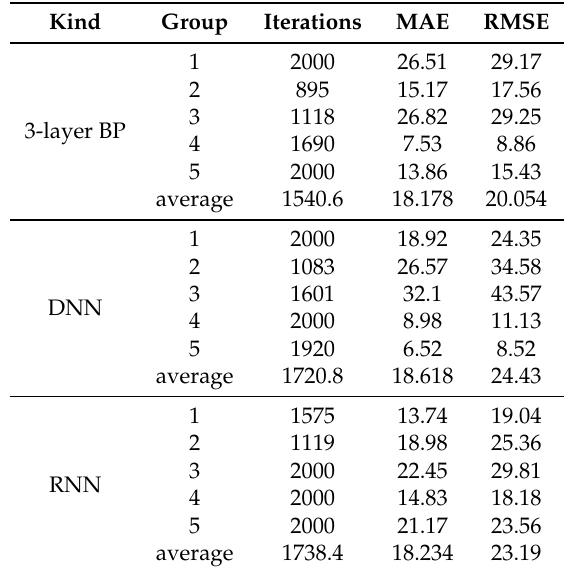
Table 2. Model Performance